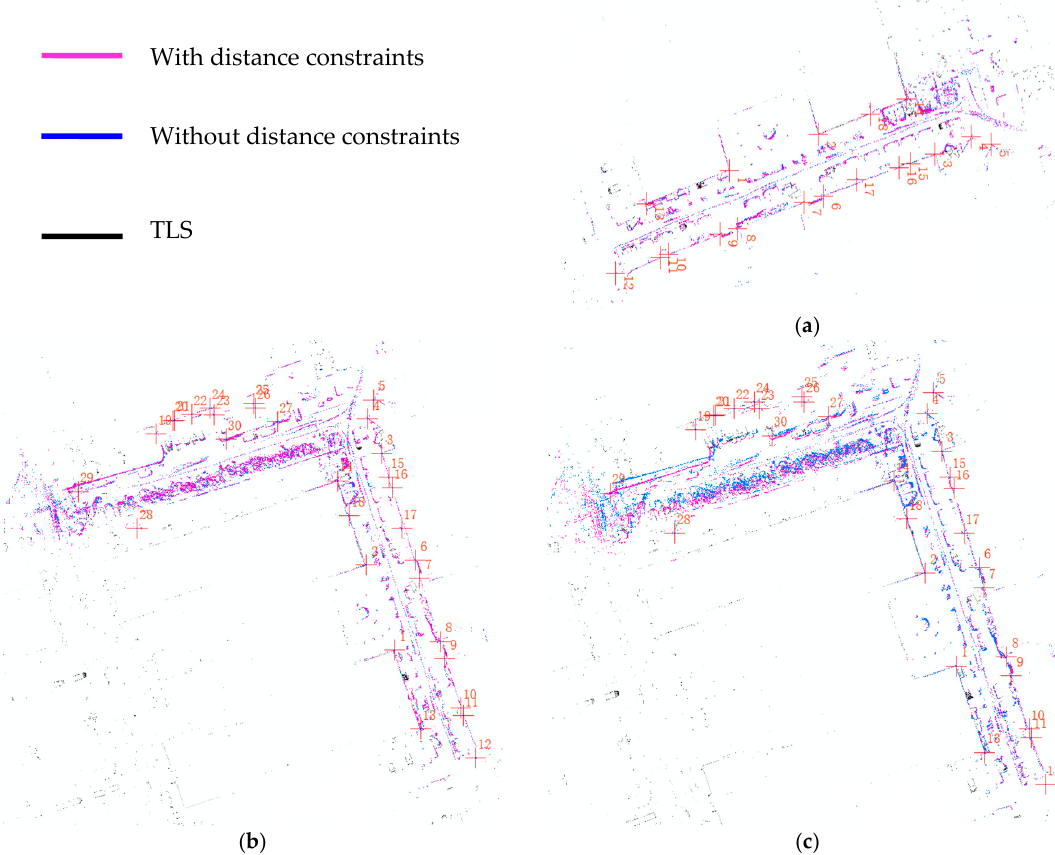
Figure 6. ( a ) result of adding one distance constraint (L1) and result without distance constraint; ( b ) result of adding two distance constraints (L1, L2) and result without distance constraint; ( c ) result of adding three distance constraints (L1, L2, L3) and result without distance constraint. Table 2. RMS of adding different numbers of distance constraints.